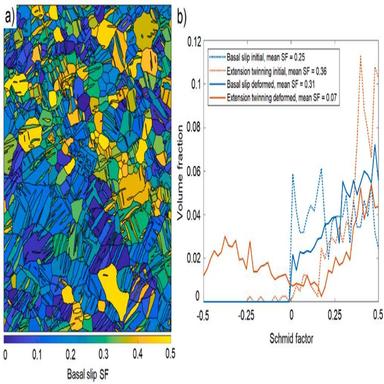
EBSD-based SF analysis of the RD sample: a) SF distribution map for the basal slip of the sample loaded up to 77 MPa, b) comparison of the SF distributions for the basal slip and extension twinning in the initial state and after loading up to 102 MPa.